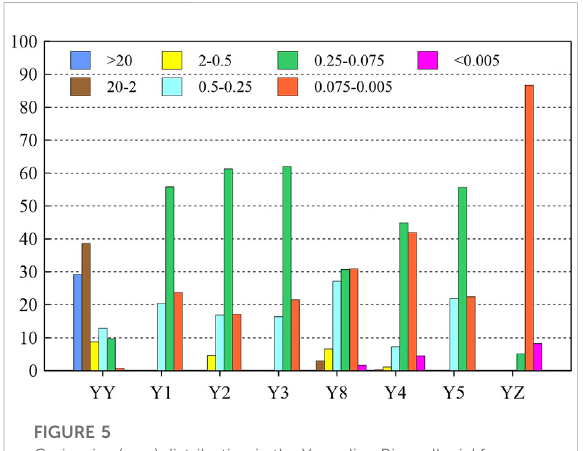
FIGURE 5 Grain-size(mm)distributionintheYongdingRiveralluvialfan.